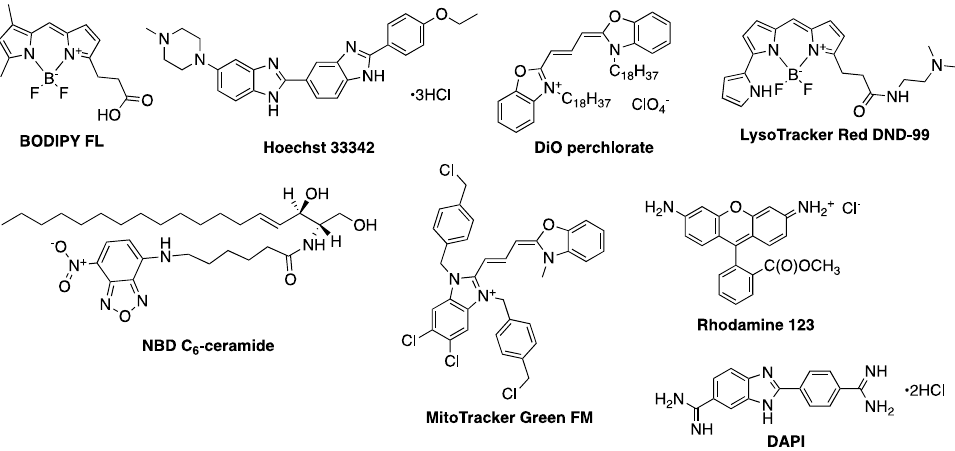
Figure 3. Structure of the most common dyes used for fluorescence cell staining.